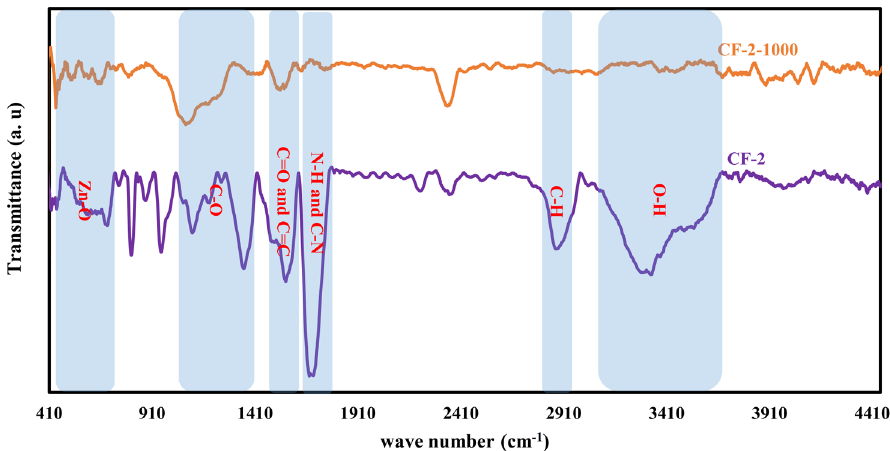
Figure 2. FTIR spectroscopy results of the synthesized (CF-2) and the pyrolyzed (CF-2-1000) carbon foam confirming the presence of C=C, C–N, C–O and C=O functional groups on the surface of the pyrolyzed